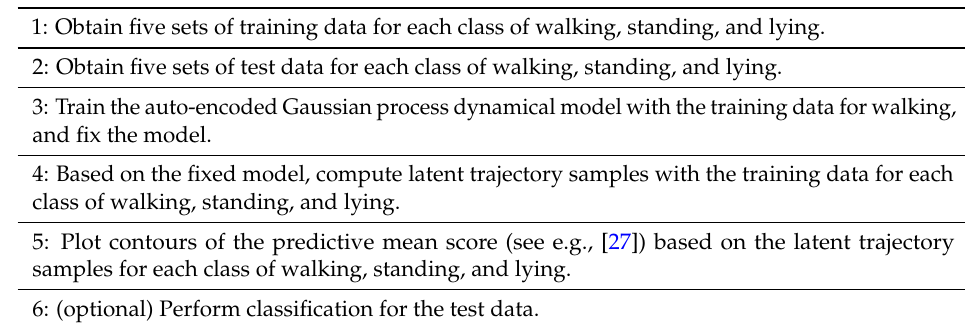
Table 2. Steps for conducting and analyzing the